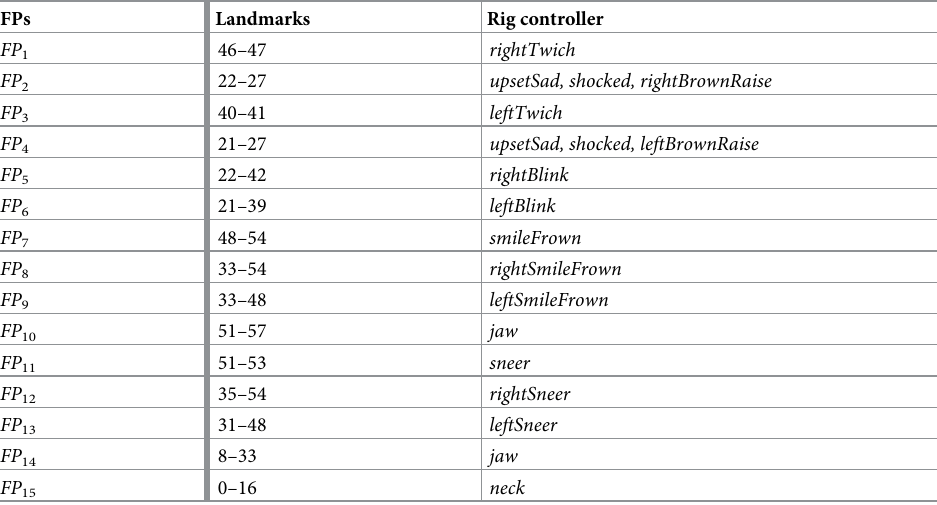
Table 2. Facial landmarks and rig controllers’ correspondences.